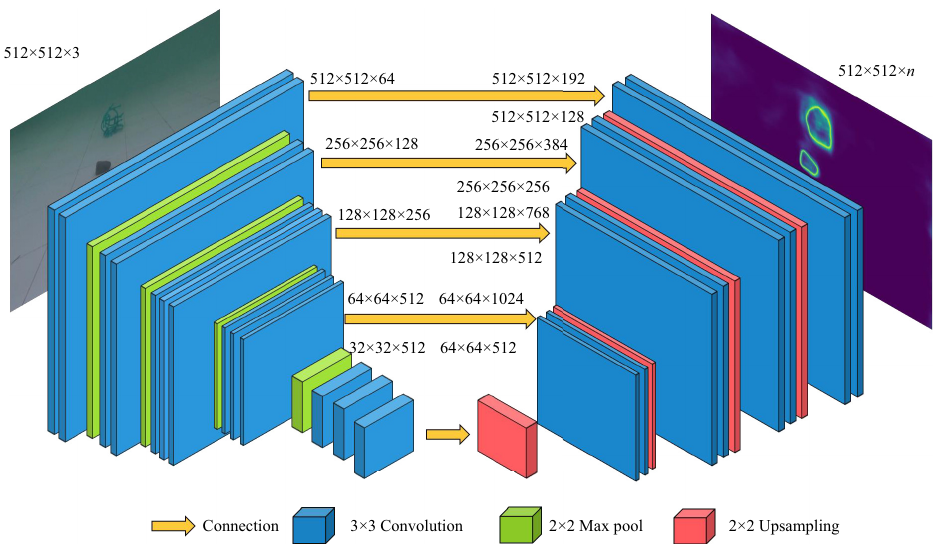
Figure 2. Modified U-Net